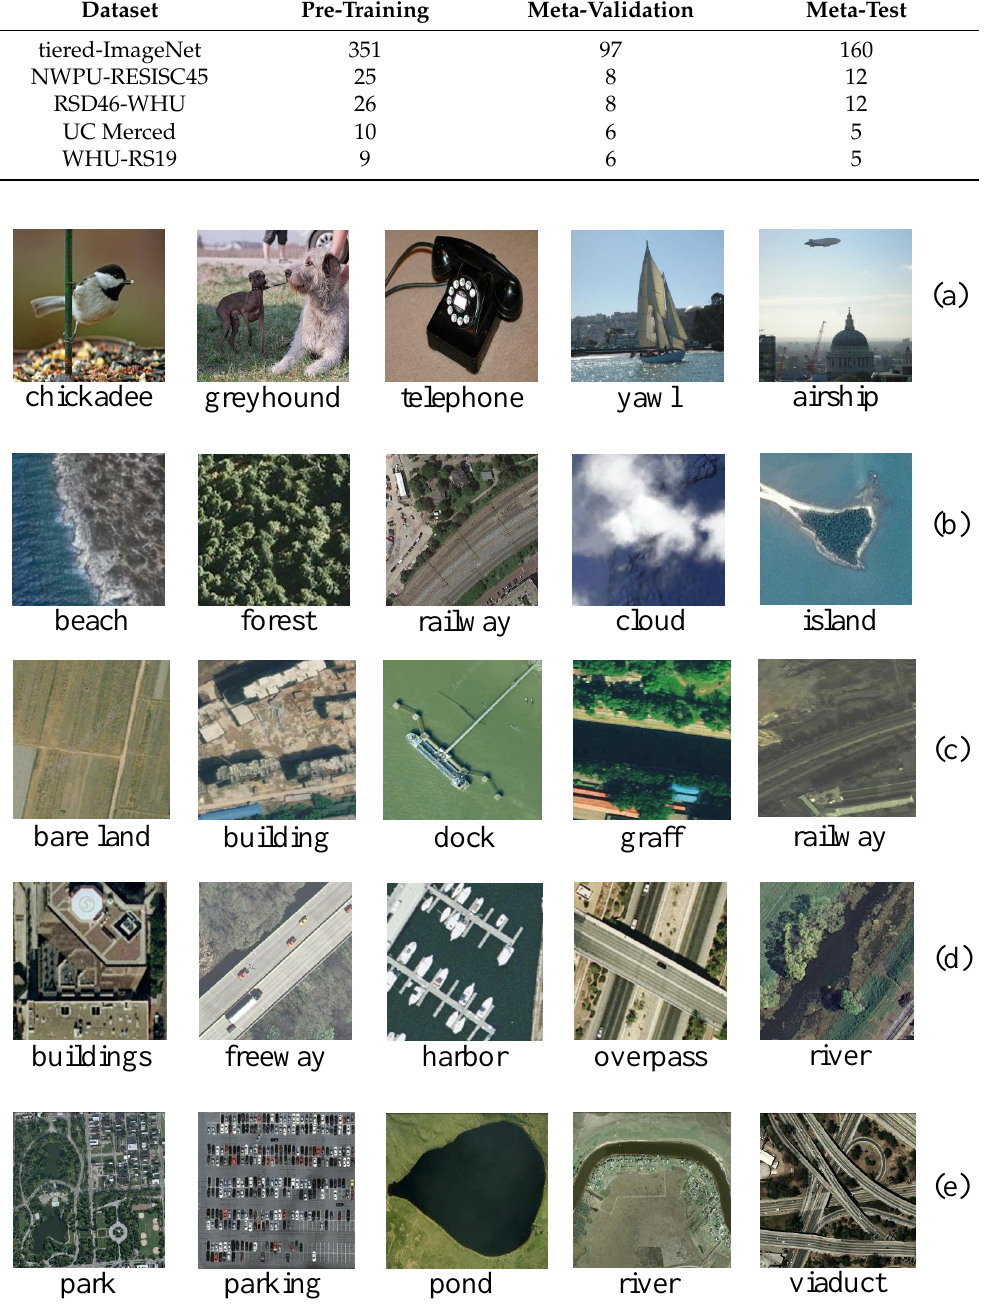
Figure 3. Example samples of the five datasets used in this paper. ( a ) tiered-ImageNet, ( b ) NWPU- RESISC45, ( c ) RSD46-WHU, ( d ) UC Merced, ( e )